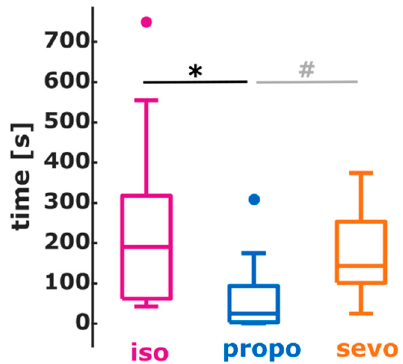
Figure 4. Boxplots representing the duration, the CSI indicated an awake patient before the return of responsiveness (ROR) for isoflurane (purple), sevoflurane (orange), and propofol (blue). For propofol, the duration was shortest with a significant (*, p < 0.001) difference compared to isoflurane and a (#, non-significant) but strong (AUC > 0.7) difference compared to sevoflurane.